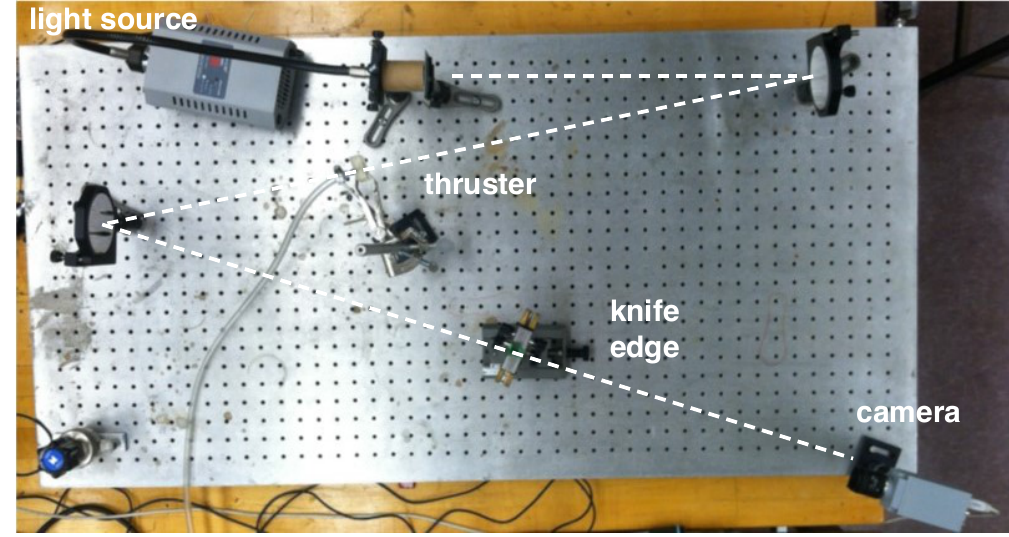
Figure 9. Optical table with a “z-type” Schlieren photography system used for flow visualization of the nozzle plume. The light source is in the top left and the camera is in the bottom right; the light path is the dashed line. The focal length of the mirror is 1 m.